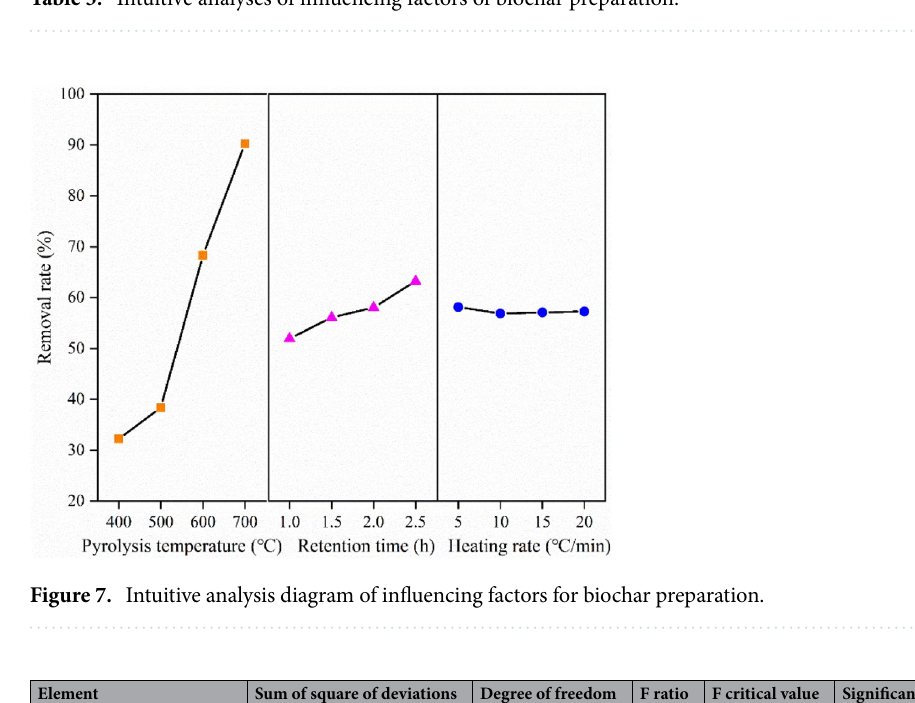
Table 3. Intuitive analyses of influencing factors of biochar preparation.